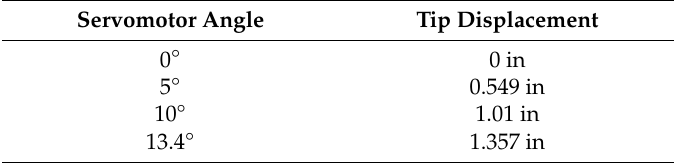
Table 3. MTE tip displacement values according to the servomotor angle of rotation.